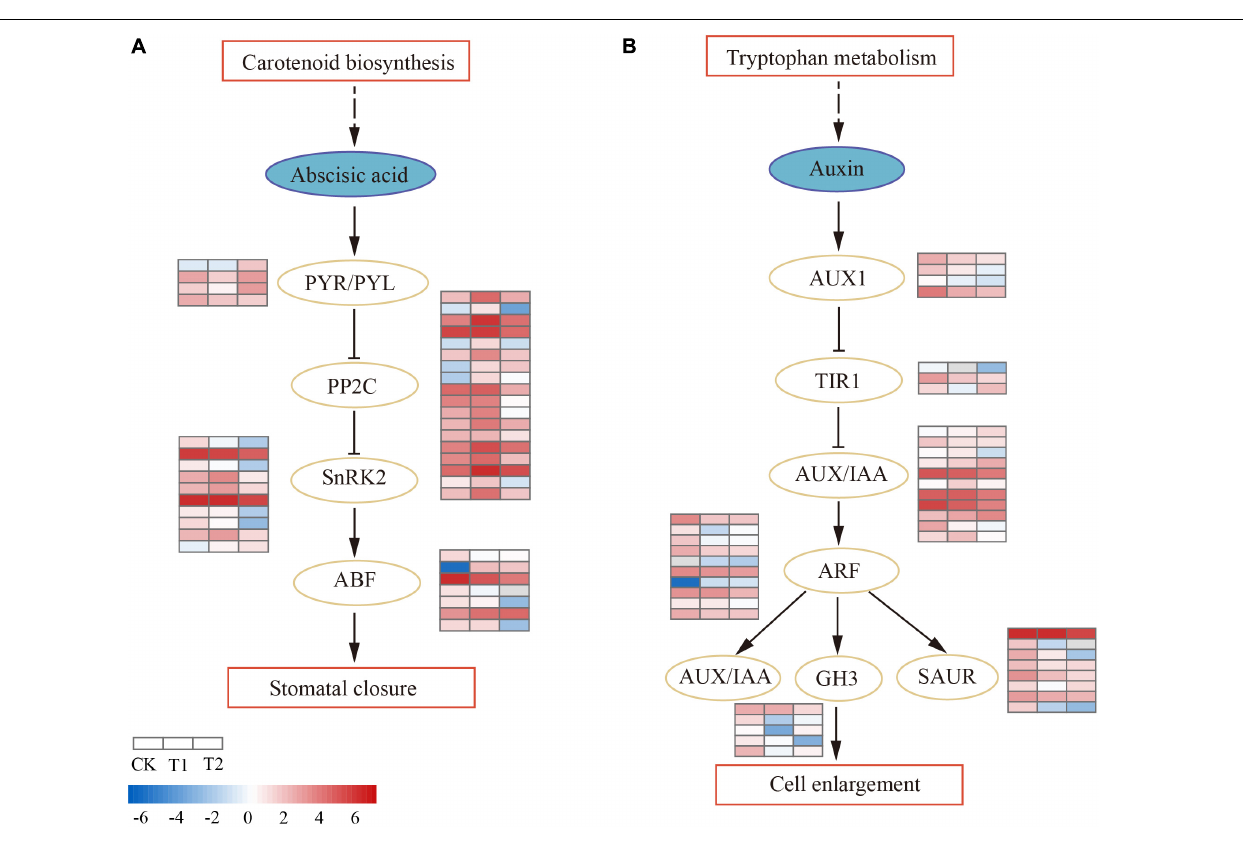
SnRK2 ( CL1848.Contig8_All ) that was upregulated in T2;